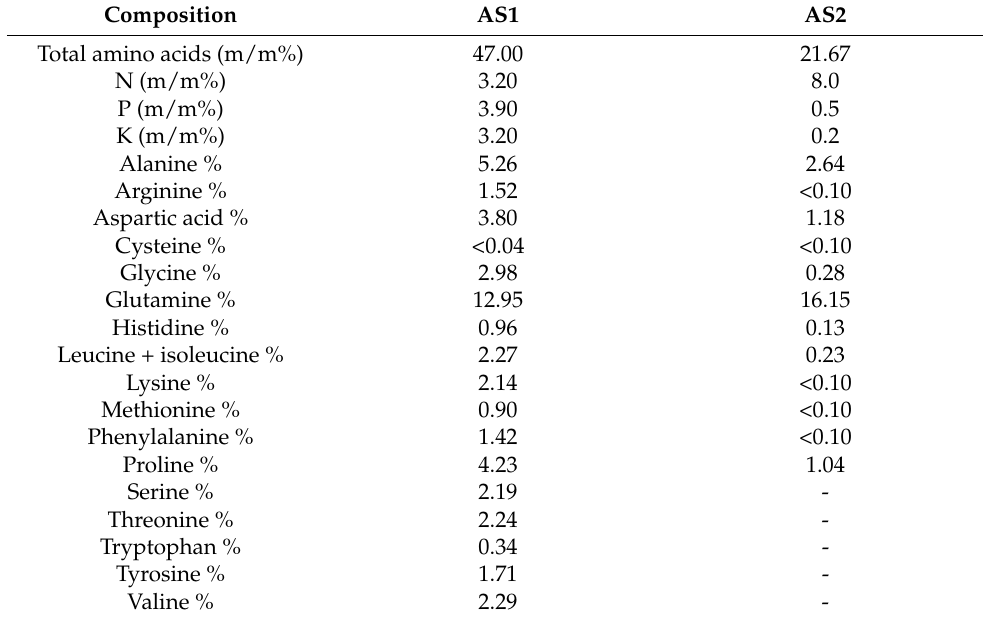
Table 2. The composition of examined amino acid-containing foliar fertilizers (AS1 and AS2). Composition AS1 AS2 Total amino acids